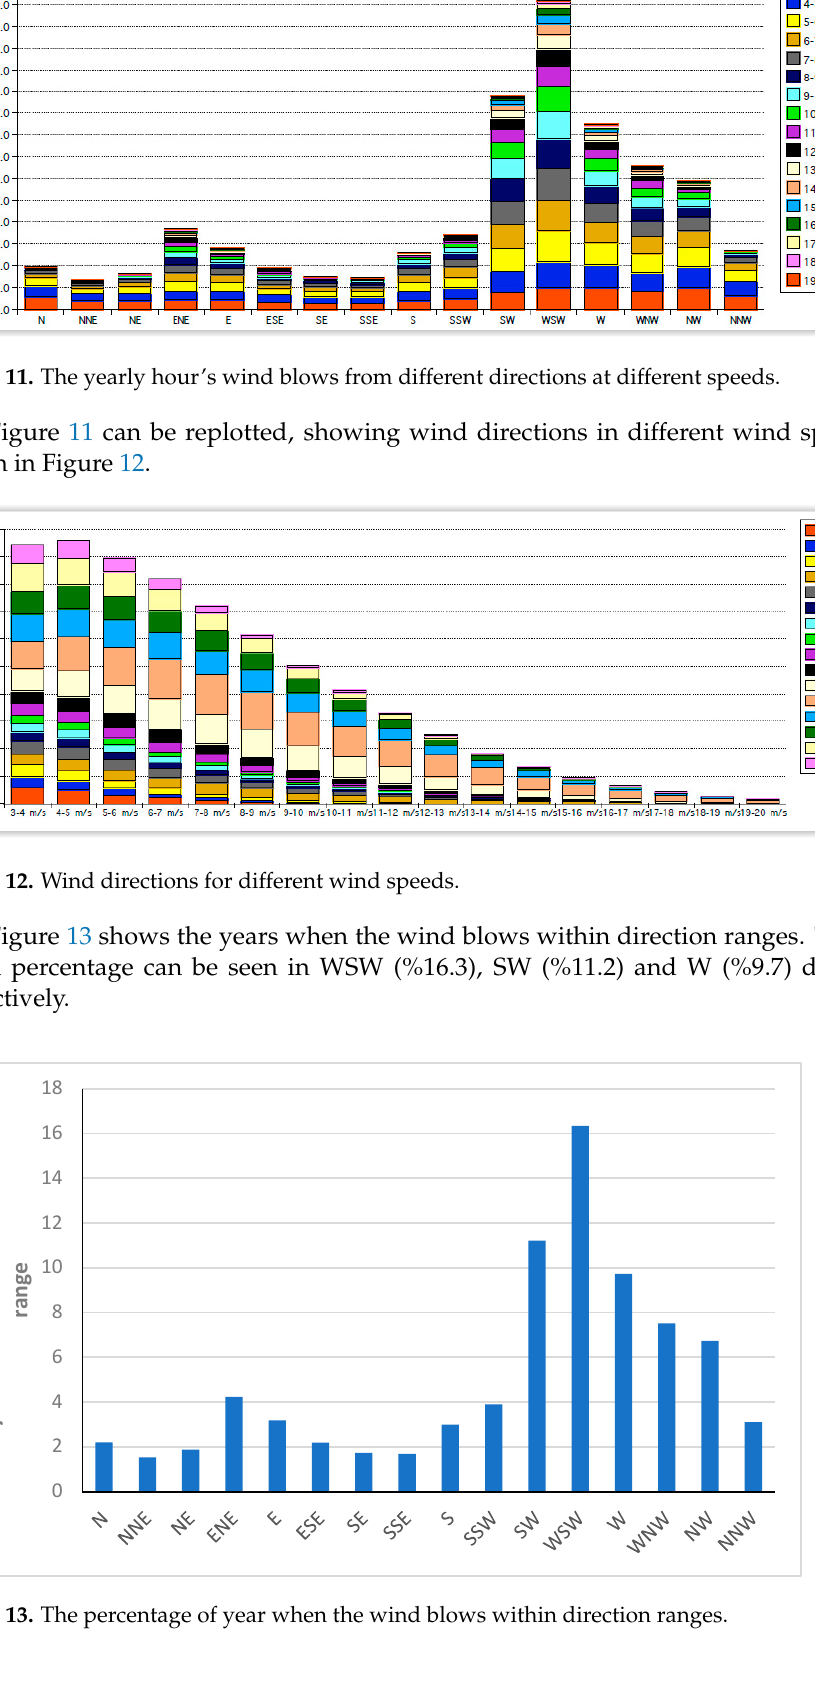
Figure 14. The annual wind run in different directions . Figure 15 shows the annual power output the turbine generates from different direc- tions. The maximum wind run can be seen in WSW (32,299 kW hours/year), SW (20,111 kW hours/year) and W (15,622 kW hours/year) directions, respectively.